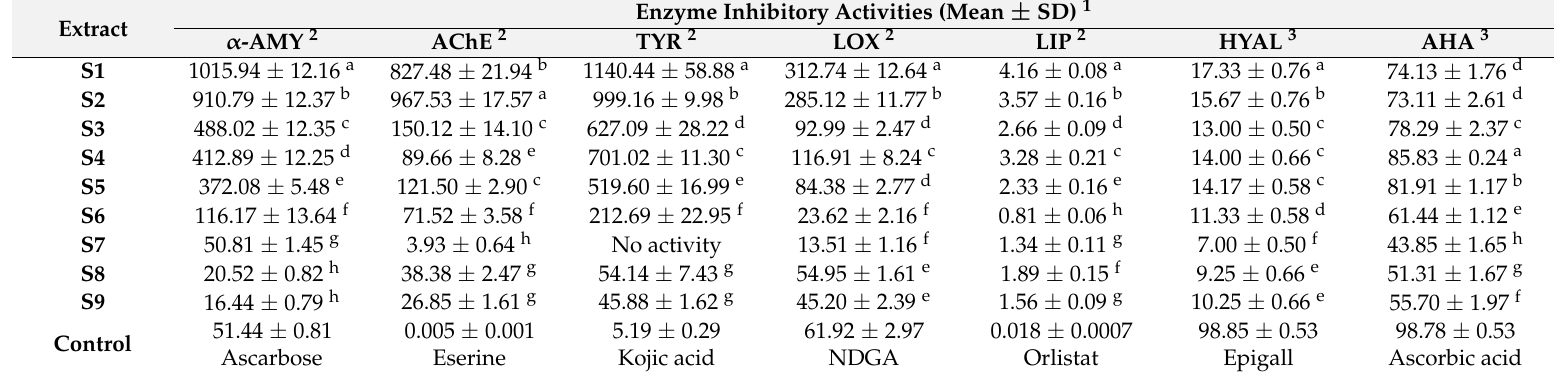
Table 3. Enzyme inhibitory activities of bee pollen extracts (mean values and standard